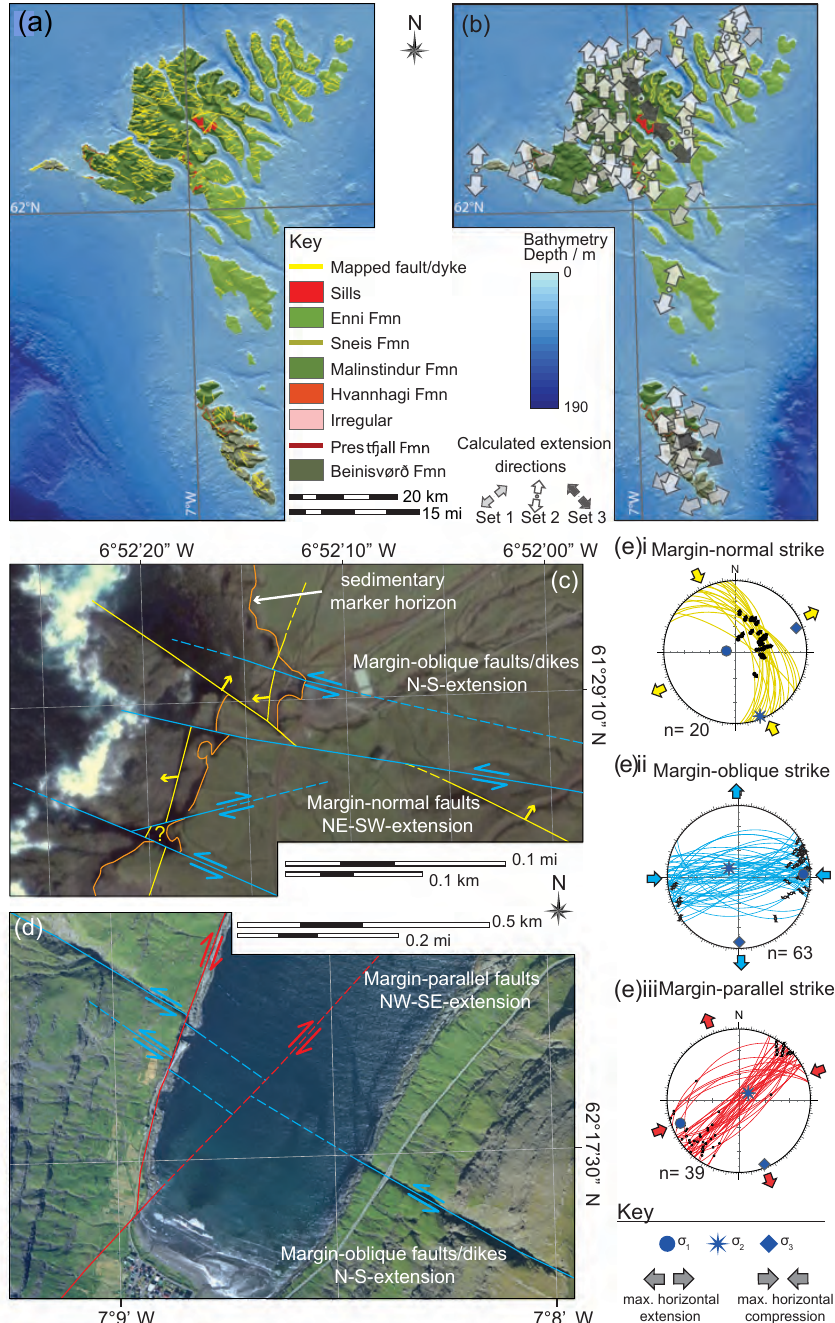
Figure 9. (a) Onshore structural element map of the Faroe Islands. (b) Inferred extension directions indicating an island-wide anticlockwise rotation in extension direction through time. (c) Margin-oblique faults cut margin-normal faults. (d) Margin-parallel faults cut rift-oblique faults and dikes. (e) Lower-hemisphere stereographic projections for relative-age-constrained examples of the three main fault sets observed.